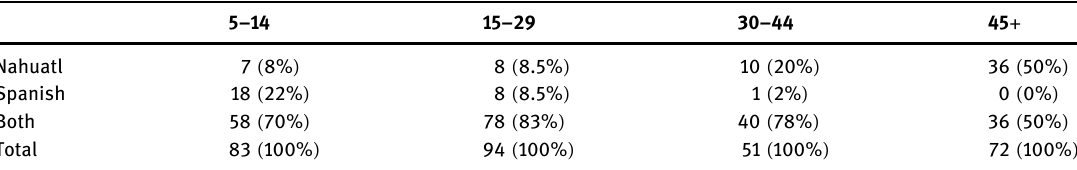
Table 6: Language use at home in di ff erent age groups ( n ( % ))